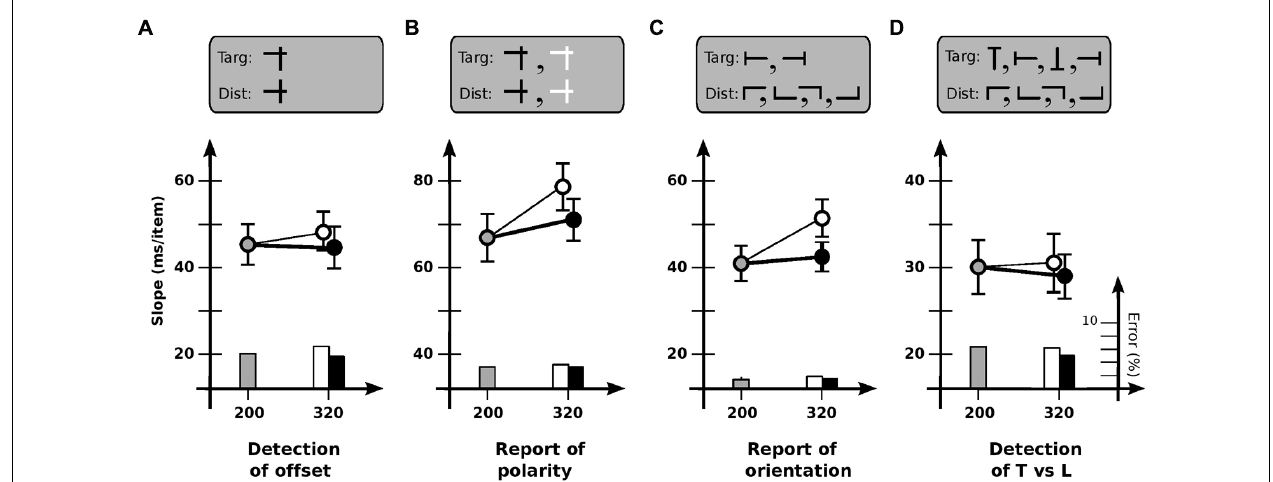
of orientation of T-shaped item. Slope for base cadence (40.8 ms/item) is affected by an increase in off-time (50.7 ms/item) but not an increase in on-time (42.0 ms/item). (D) Detection of T-shaped item. Slope for base cadence (30.0 ms/item) is unaffected by an increase in off-time (30.5 ms/item) or on-time (28.2 ms/item). Error bars indicate standard error of the